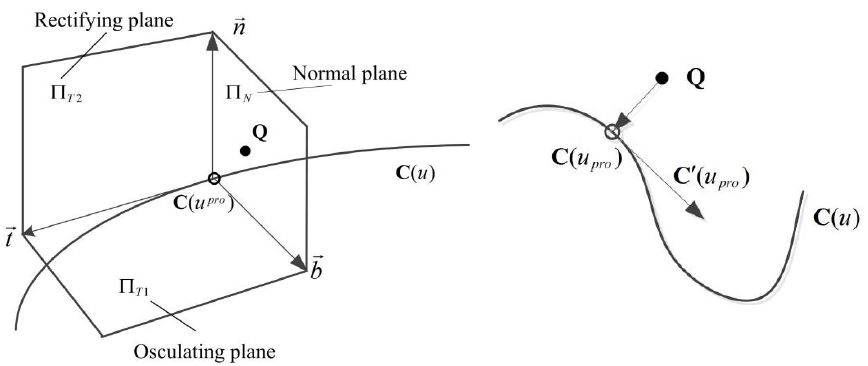
Figure 2. The projection point in a curve.